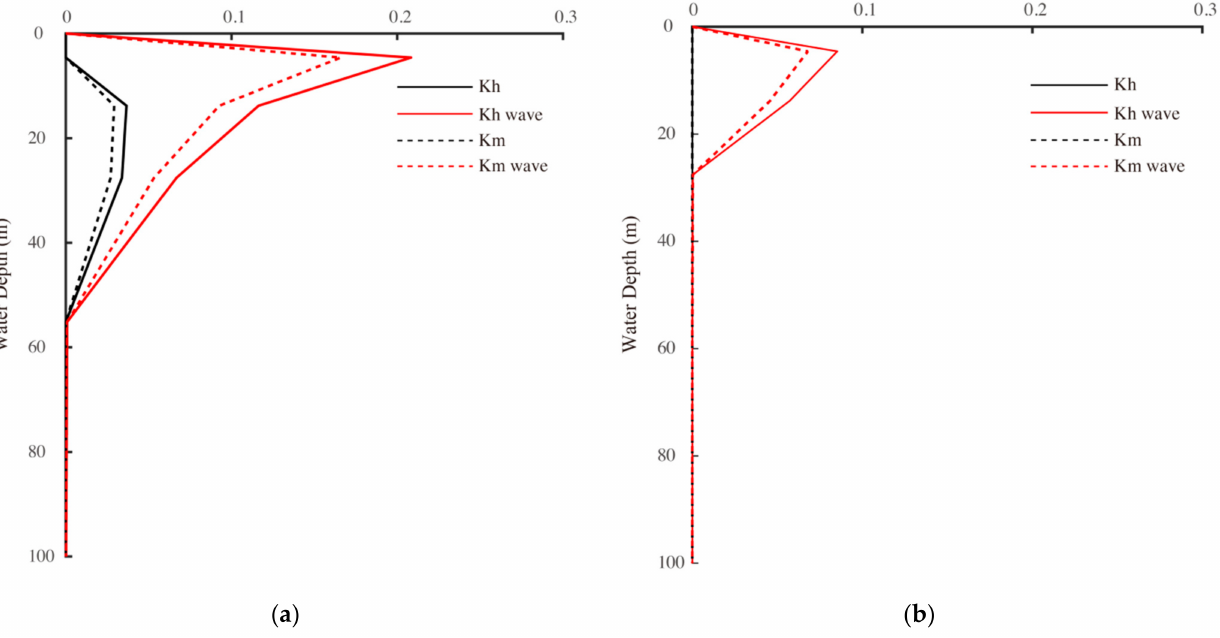
Figure 11. ( a ) The vertical mixing profile on 27 and 28 August 2012 at Site A in Figure 10a, and ( b ) the vertical mixing profile on 10 and 11 July 2015 at Site B in ( a ). Note that K h represents the mixing induced by heat flux, and K m represents the mixing induced by